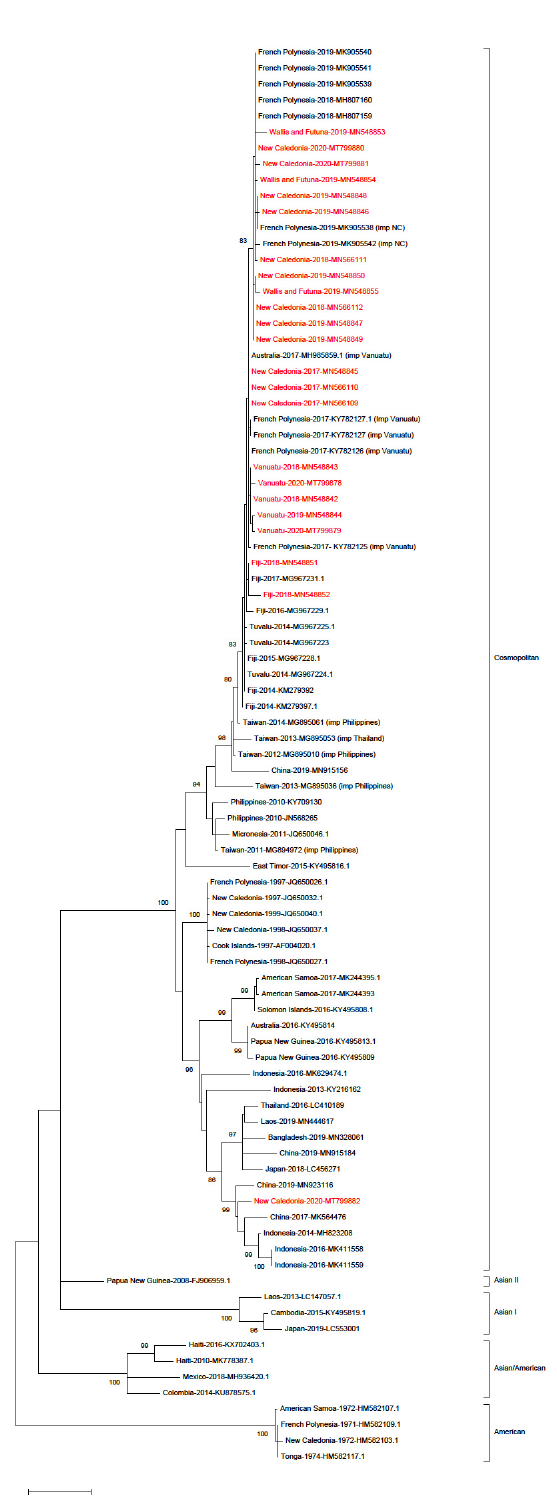
Figure 2. Maximum likelihood evolutionary (MLE) relationships of DENV ‐ 2 E gene sequences. Maximum likelihood tree derived from 89 DENV ‐ 2 E gene sequences (23 from Fiji, Vanuatu, Wallis and Futuna, and New Caledonia in red, and 66 from the 5 genotypes retrieved from GenBank, including isolates collected in 2010–2019 in the Pacific and in South East Asia). The percentage of replicate trees in which the associated taxa clustered together in the bootstrap test (1000 replicates) is shown for values over 80. The country and year of collection are indicated along with the GenBank accession number; imp = imported